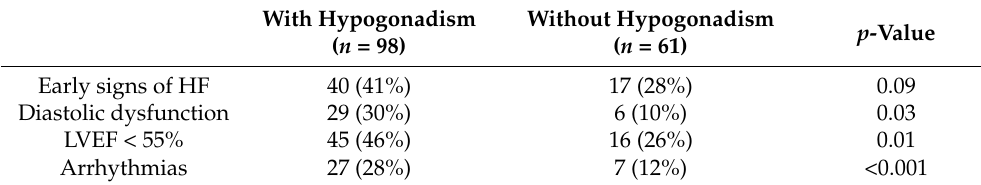
Table 7. Cardiovascular outcomes and